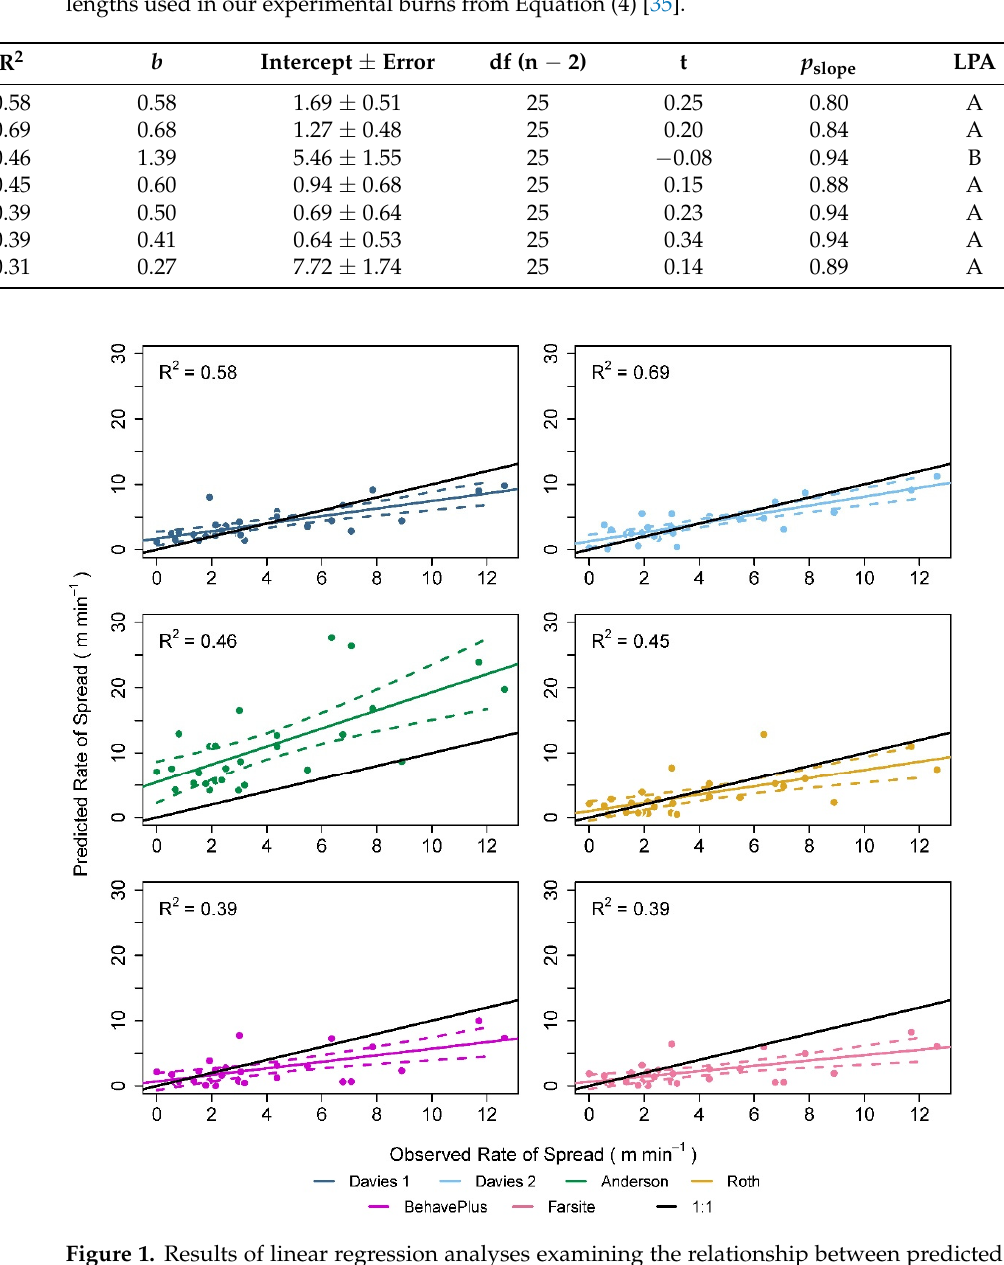
Table 2. Performance of each modeling technique versus observed fire behaviour. ‘Model’ is fire behaviour linear model. ‘R 2 ′ is the adjusted correlation for each regression. ‘ b ’ is the coefficient of each regression. ‘df’ is n − 2 degrees of freedom. ‘t’ is the test statistic for performance testing. ‘ p slope ’ is a significance value for differences between the slope of each regression line and the 1:1 LPA, based on the t-statistic. For any non-significant p -value based on α = 0.05, ‘LPA’ represents where the LPA resides relative to the 95% confidence intervals of each regression line: W is within, A is above, and B is below. Corrected is Anderson versus corrected observations of rates of spread for ignition line lengths used in our experimental burns from Equation (4) [35].